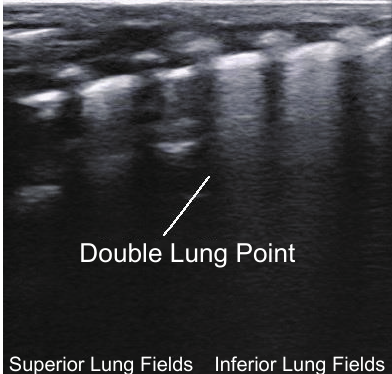
Figure 6 Double lung point, a sharp cut off point resulting arising due to more compact B-lines in lower and less compact B-lines in upper lung